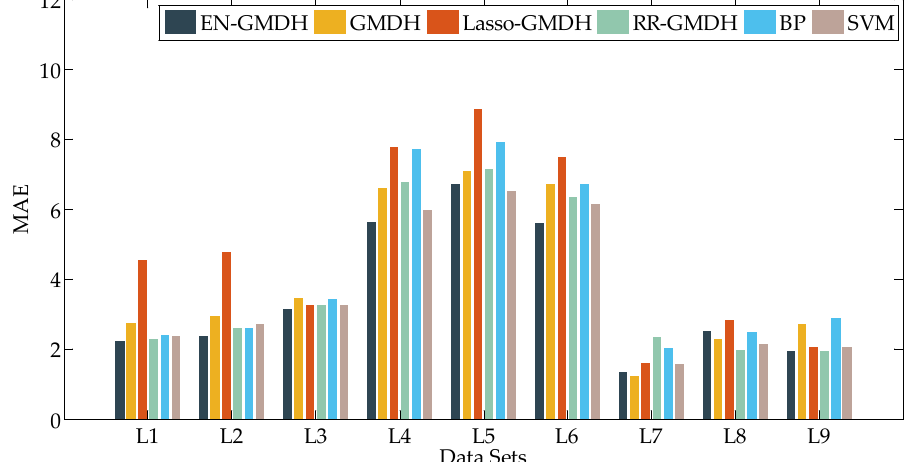
Figure 9. Results of MAE in data sets (L1 to L9). RR: ridge regression; BP: back propagation; SVM: support vector